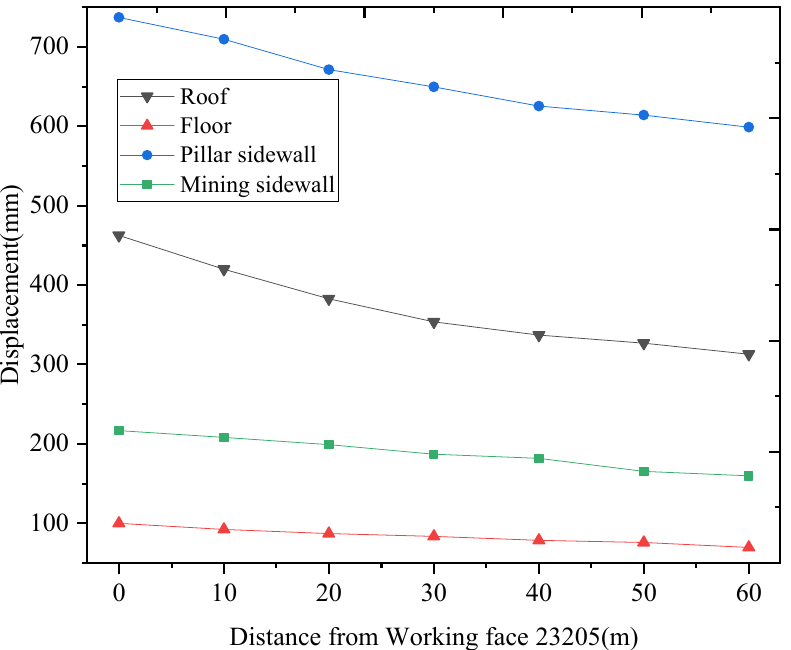
Figure 14. Displacement of the roadway ‐ surrounding rock at different distances from the front of working face 23205 during the second mining.